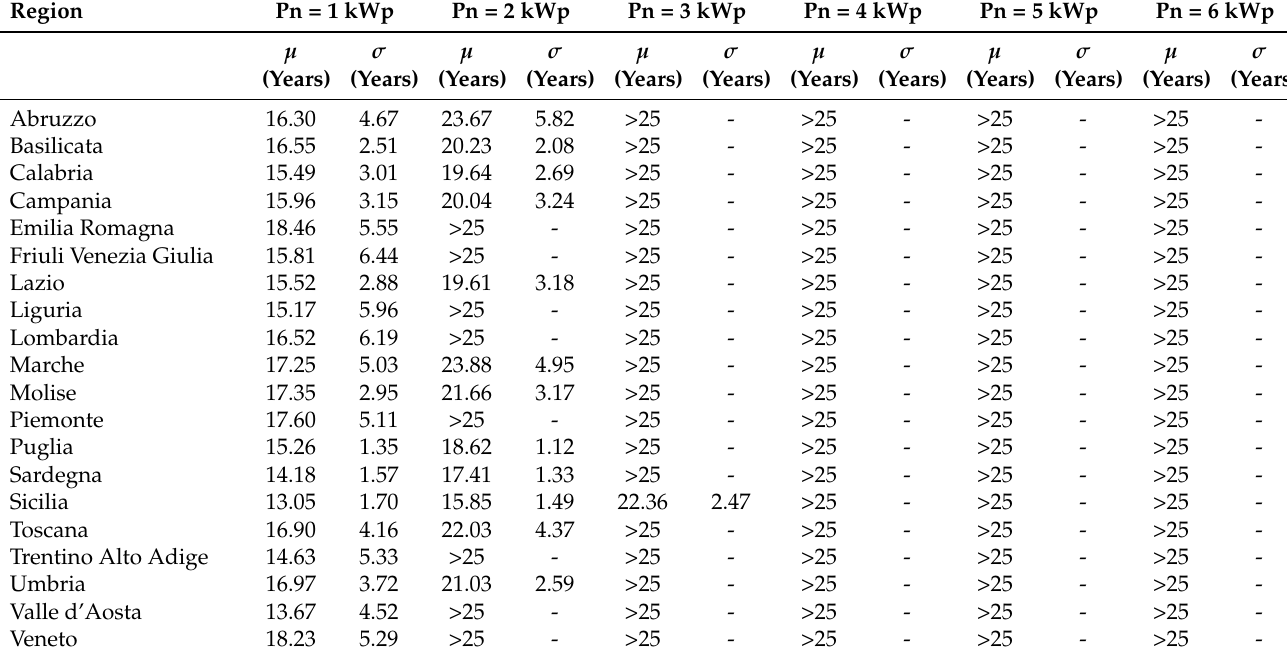
Table 9. Discounted Pay Back Time (DPBT) for E L = 2700 kWh without